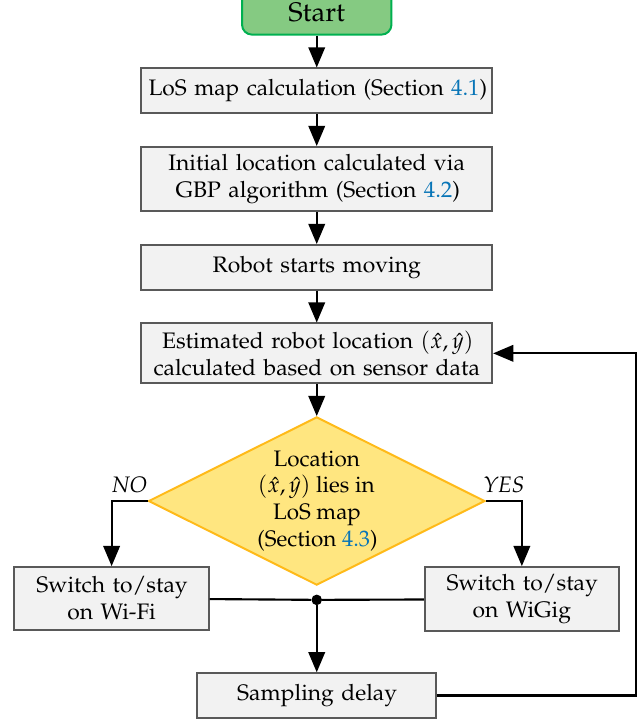
Figure 5. Procedures of the roposed LHO